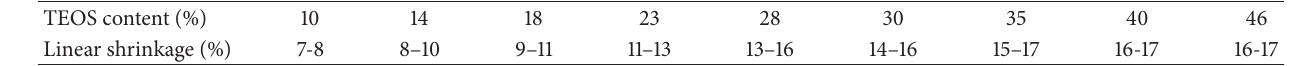
Table 1: Linear shrinkage of neutrally catalyzed aerogels versus the TEOS concentration.